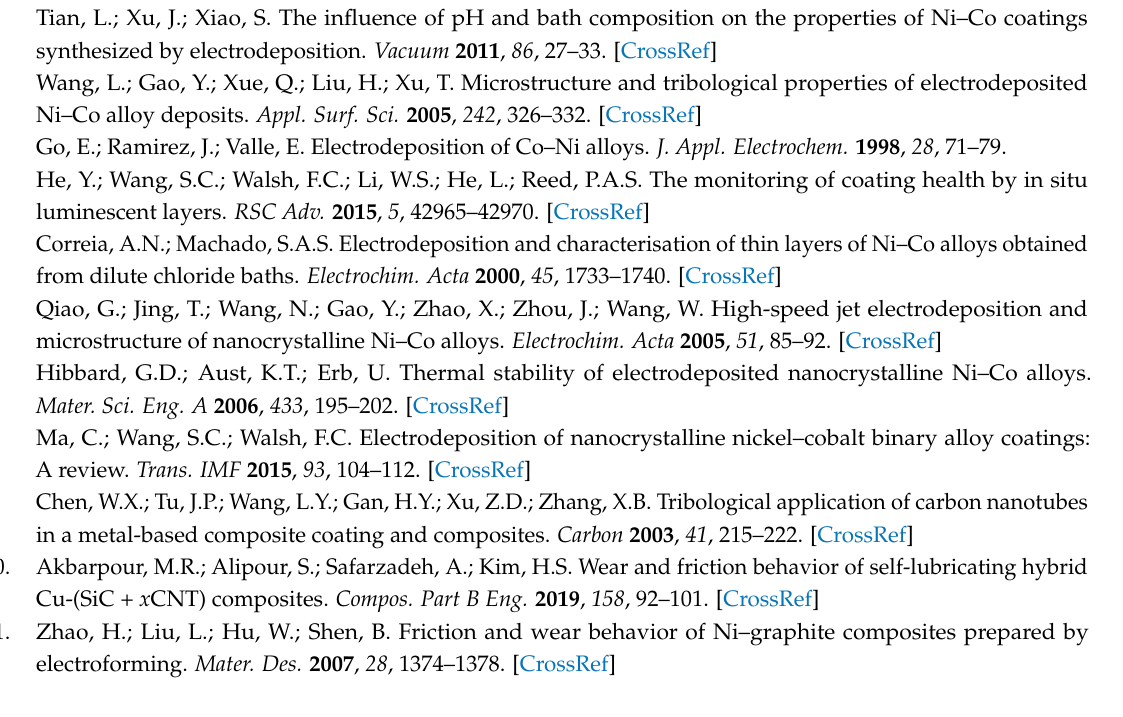
Figure 12. ( a ) Low- and ( b ) high- magnification SEM images of the cross-section of a Ni–Co/WS 2 7.1 wt.%